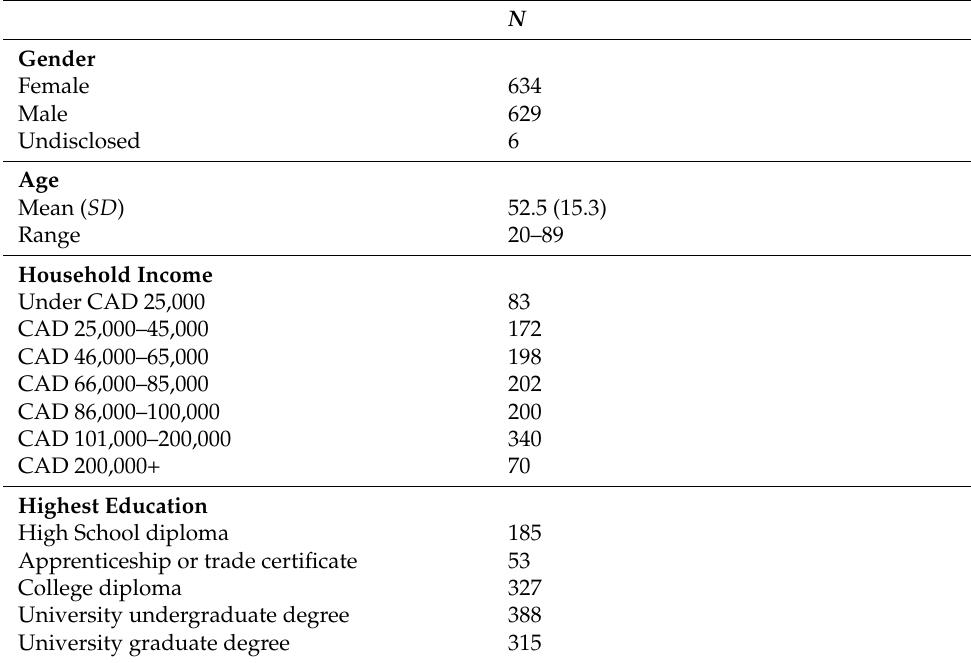
Table 1. Breakdown of demographics ( N =